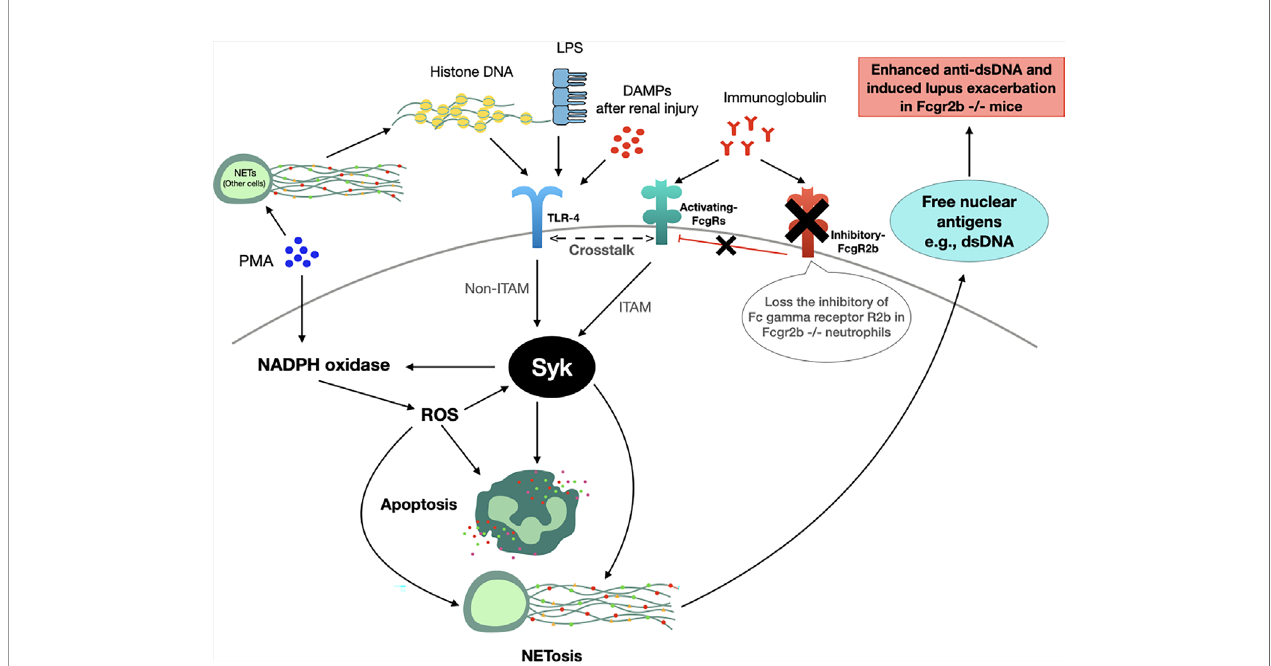
FIGURE 12 | The working hypothesis. Spleen tyrosine kinase (Syk) is a possible shared-downstream signaling of i) reactive oxygen species (ROS) derived from NADPH oxidase 2 (NOX2)-dependent PMA stimulation (100), ii) direct TLR-4 activation through DAMPs (damage associated molecular patterns) from renal ischemia (in mice) or lipopolysaccharide (LPS) ( in vitro ), iii) indirect TLR-4 activation from DNA histone released from PMA-induced NETosis (99) and iv) Fc gamma receptors (FcgRs) (98). Indeed, Syk, activated through immunoreceptor tyrosine-based activation motif (ITAM) and non-ITAM dependent signals from FcgRs and TLR-4, respectively (37), could enhance both apoptosis (2 h post-stimulation) and NETosis (4 h post-stimulation) (100, 101). Hence, prominent Syk activation in Fcgr2b-/- neutrophils compared with wild-type (WT) might be due to the crosslink between TLR-4 and activating-FcgRs (20, 21, 58) without the inhibitory receptor (blue cross line). After that, the profound free nuclear antigens, including dsDNA, from apoptosis and NETosis exacerbates lupus activity from the prominent anti-dsDNA production in Fcgr2b-/- mice but not in WT (+ve, positive signal; -ve, negative